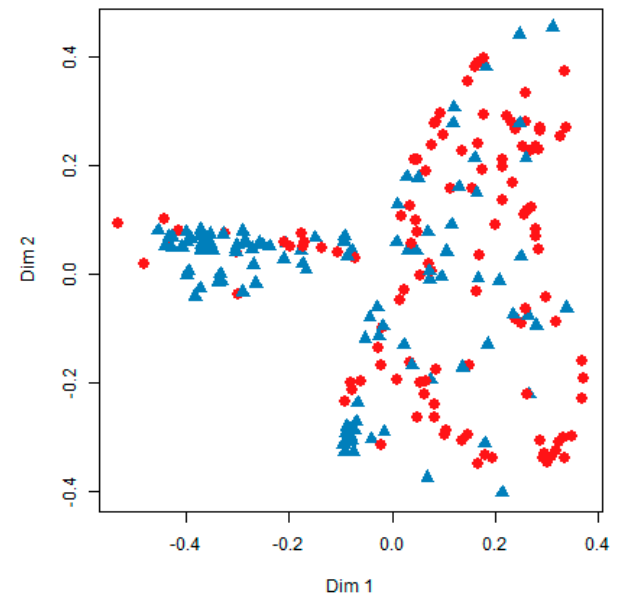
Figure 5. Multidimensional scale plots in random forest. Blue = AD; red = PDD.